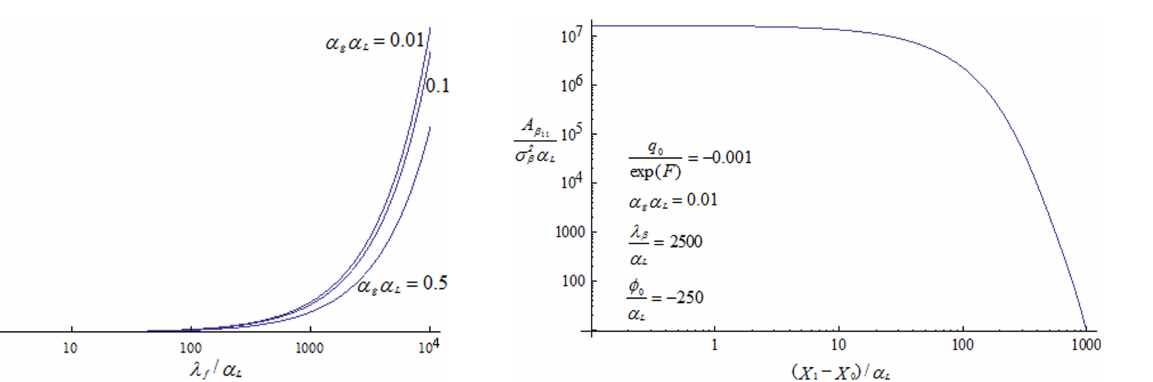
Fig. 3. Dimensionless component of the longitudinal macrodis- persivity as a function of dimensionless position, where the dimensionless flow domain we investigate corresponds to 0 < ( X 1 − X 0 )/ α L < ( X L − X 0 ) / α L , and ( X 1 − X 0 )/ α L =0 corre- sponds to the location of the bottom of the flow